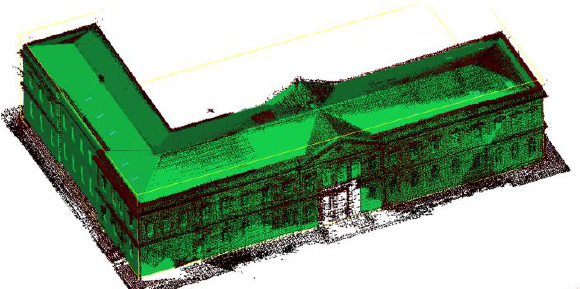
Figure 8 Overlapping of point-cloud (red) with elements designed in ArchiCAD.